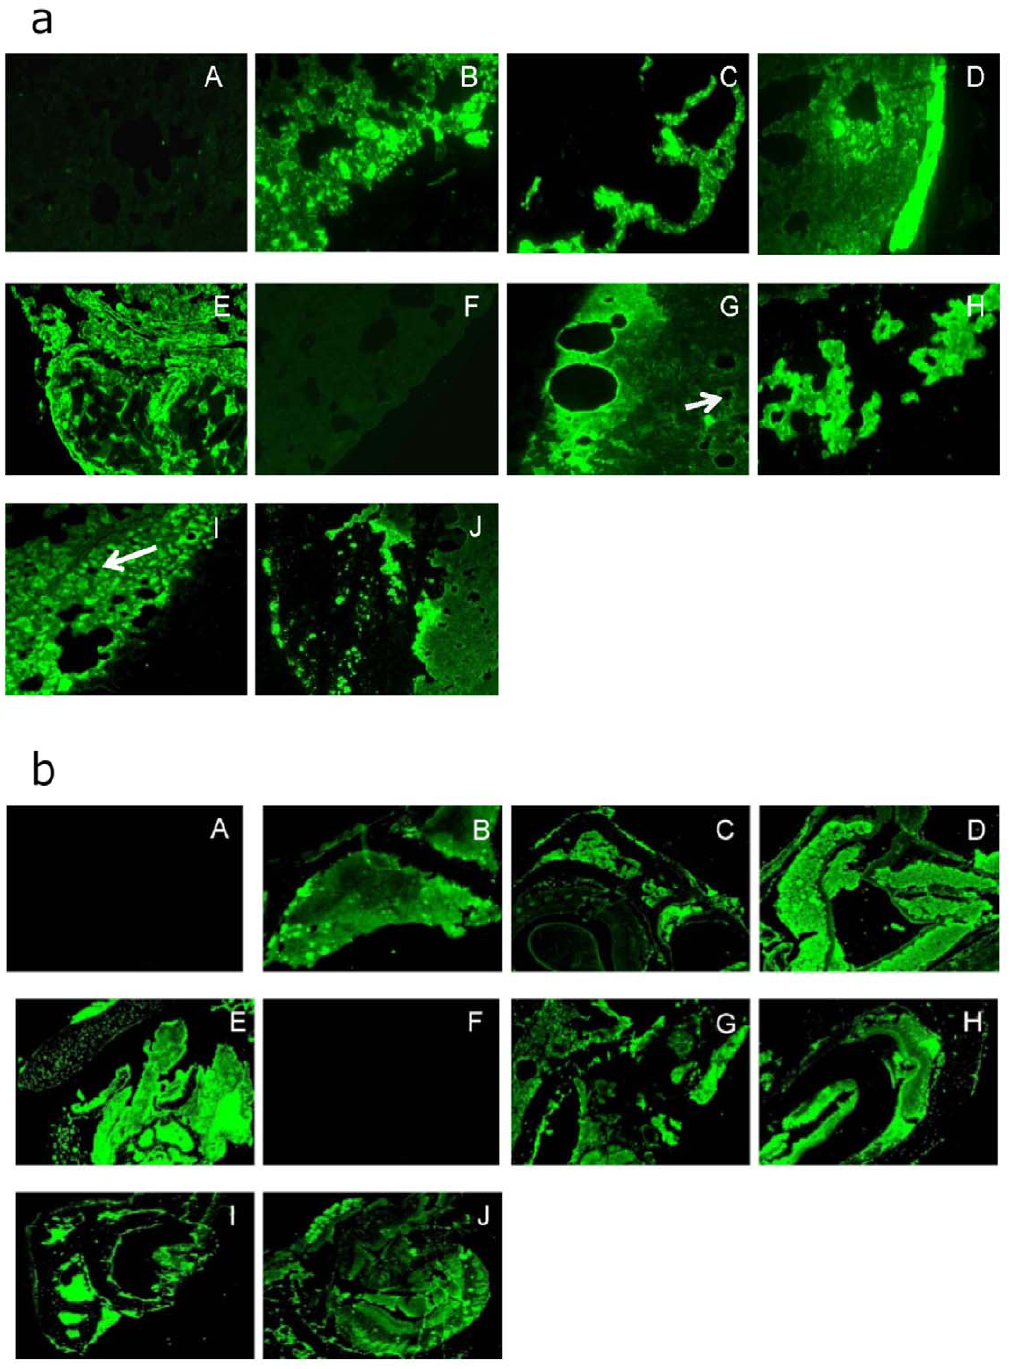
Figure 3. Immunohistochemistry of sections of lungs (3a) and nasal turbinates (3b) harvested from mice 3 dpi with each of the 9 APMV serotypes. Mice were mock-infected (panel A) or infected with APMV-1 (panel B), APMV-2 (panel C), APMV-3 (panel D), APMV-4 (panel E), APMV-5 (panel F), APMV-6 (panel G), APMV-7 (panel H), APMV-8 (panel I), and APMV-9 (panel J). Immunofluoresence was performed with polyclonal antiserum specific to the respective serotype N protein (magnification, 6 400). In sections of the lungs from mice infected with different APMVs, immunofluorescence was evident around the bronchial epithelium (Fig. 3a). In sections of the nasal turbinates from mice infected with different APMVs, immunofluorescence was evident around the bronchial epithelium, at the apical surface of the ciliated epithelial cells and in the cytoplasm (Fig. 3b). Bronchioles are shown by arrow. doi:10.1371/journal.pone.0016776.g003 were more severe in the alveoli and interstitial tissue, and were less tissues infected with APMV-1 and APMV-2, while mild to subacute severe in the airways. Severe multifocal to coalescing acute bronchointerstitial pneumonia was observed in the other APMVs necrotizing bronchointerstitial pneumonia was noticed in lung infected mice (Fig. 4). There was involvement of bronchiolar